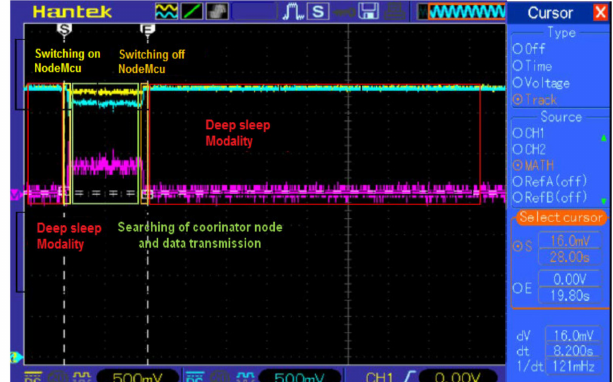
Figure 14. Oscilloscope traces related to the voltage drop on the 4 Ω sensing resistor (yellow and light blue) during a successful connection of the sensor node with the coordinator node. The time duration to complete the acquisition and transmission phase is equal to 8.2 s.